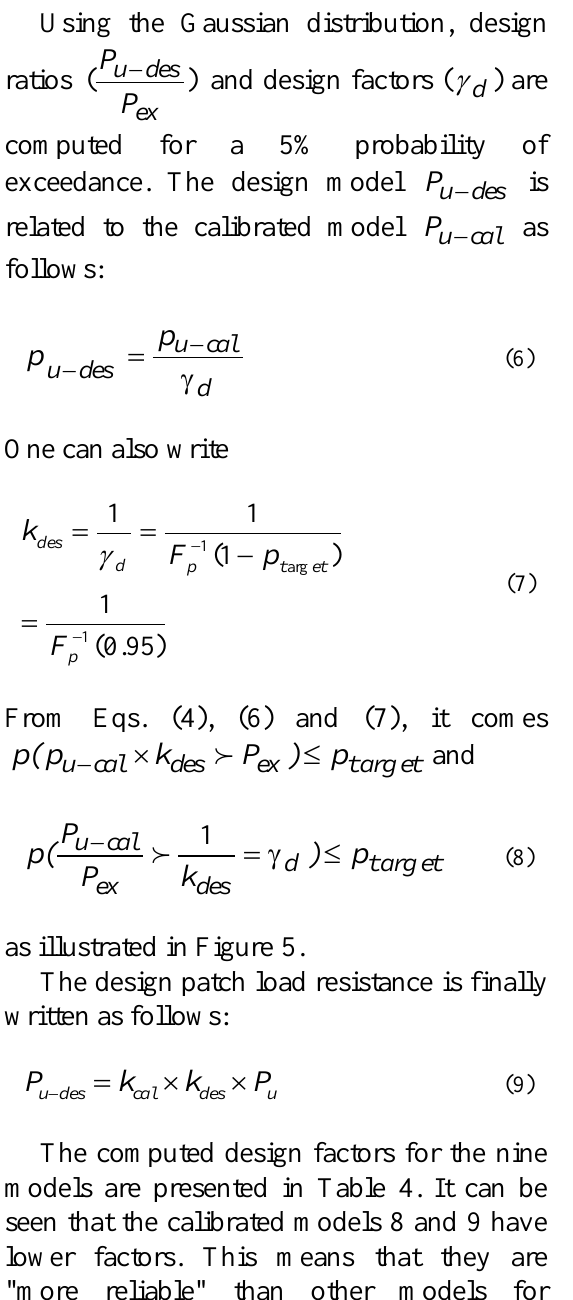
Table 4. Design factor